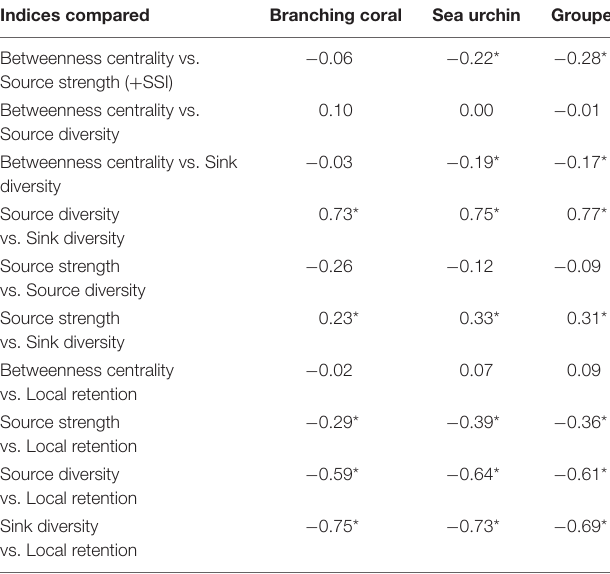
TABLE 3 | Pairwise comparison between connectivity indices for each organism